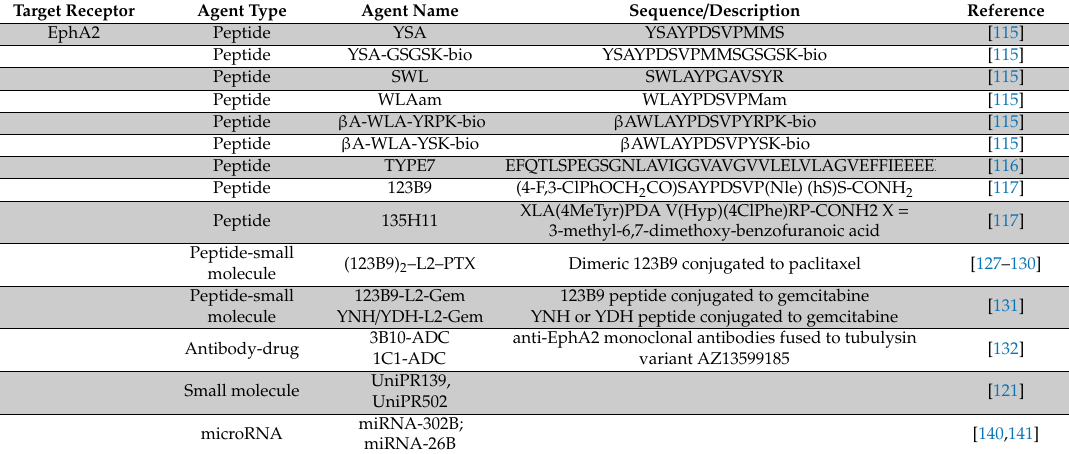
Table 1. Peptides, proteins, and small molecules developed to target Eph